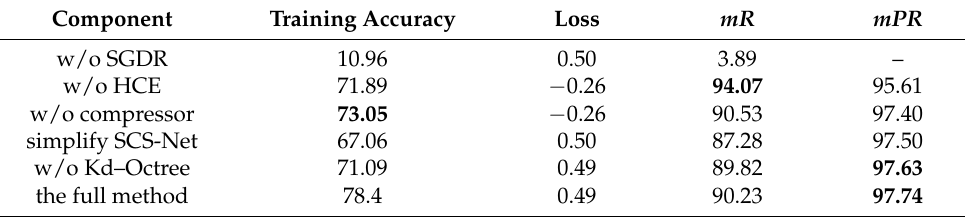
Table 6. The score of network training and feature matching of all ablated experiments on